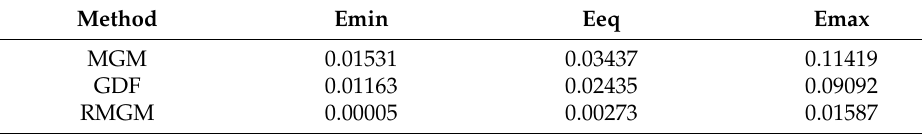
Figure 19. Comparison of the prediction errors of GDF, MGM, and RMGM. Table 7. Comparison of the composite position error calculated by three